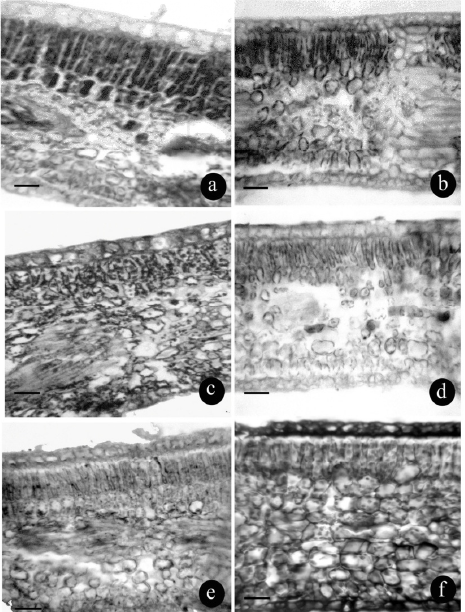
Fig. 5. Anatomical features of the leaf lamina in M. indica varieties, magnification bar: a to f – 10 mm a. ‘Jahangir’- 3 pallisade layer, spongy layer cells loosely arranged; b. ‘Totapuri’- single pallisade layer, spongy layer cells loosely arranged; c. ‘Jhamrukhiyo’- single layered pallisade, spongy layer cells loosely arranged; d. ‘Kaju’- 2 pallisade layer, spongy layer cells loosely arranged; e. ‘Aamirpsand’- 2 pallisade layer, spongy layer cells loosely arranged; f. ‘Gajariyo’ – single layered pallisade, spongy layer cells compactly